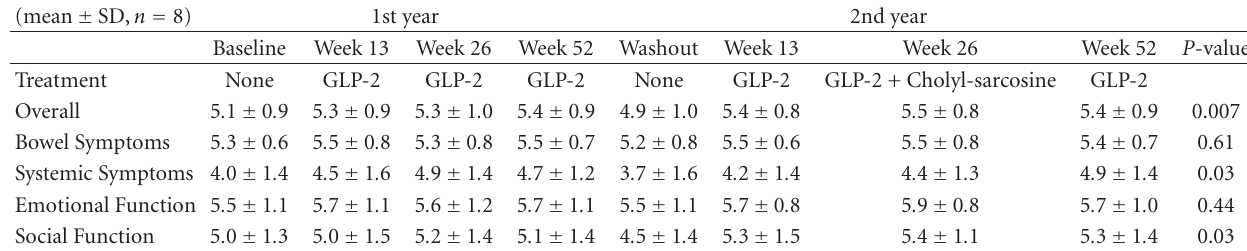
Table 4: Inflammatory Bowel Disease Questionnaire, IBDQ (7 ∼